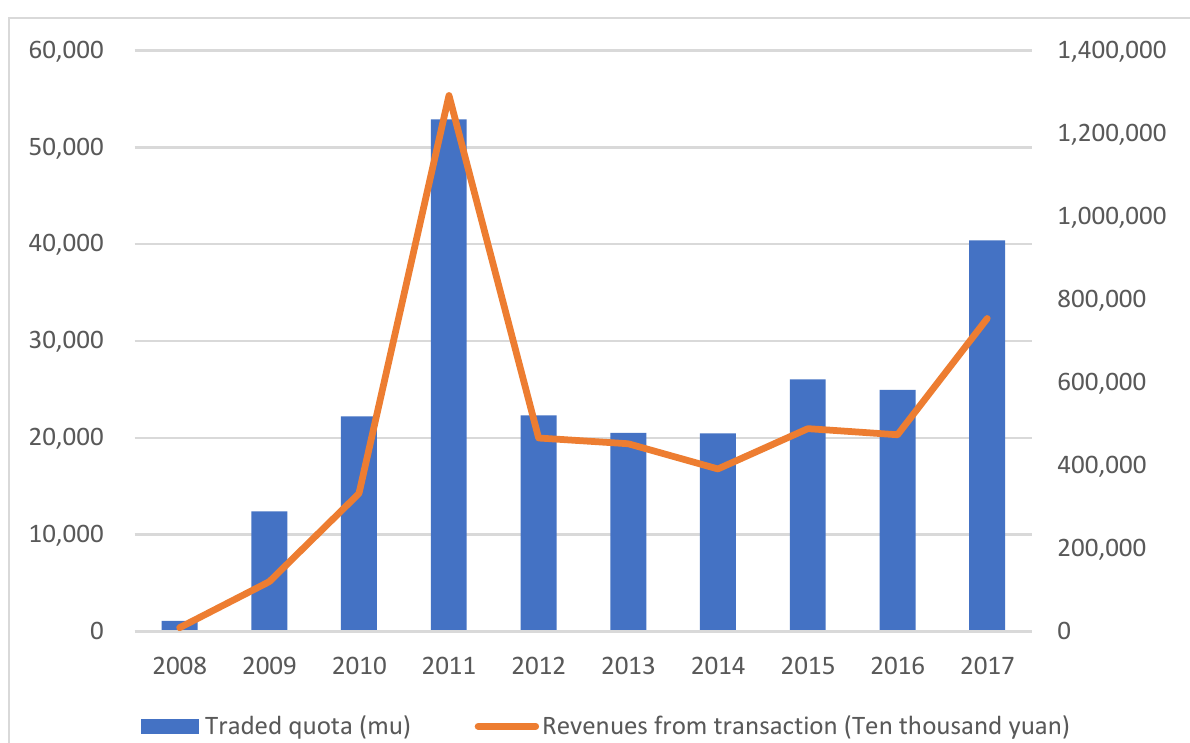
Figure 3. Trend of land ticket transactions from 2008 to 2017.